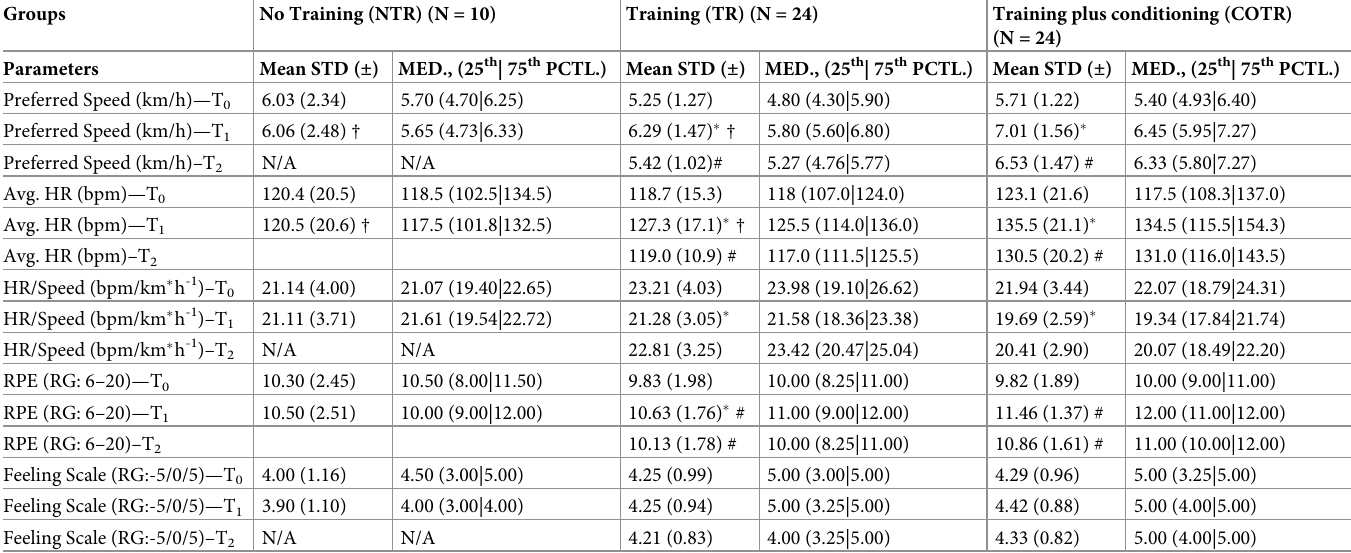
Table 2. Exercise trial characteristics for no training (NTR), training (TR), and Conditioning Training (COTR) groups.